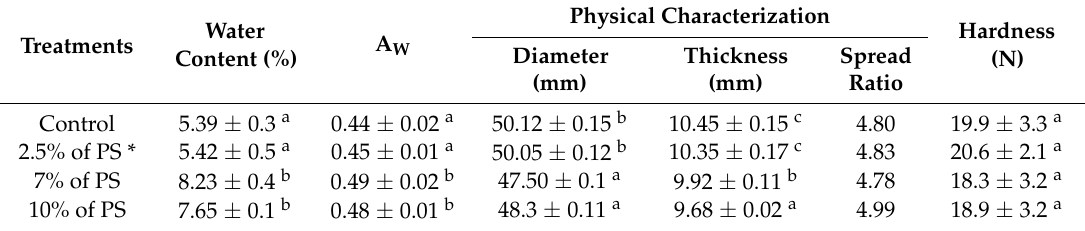
Table 5. Water content, A W , physical characterization, and texture analysis of the resulting cookies with added citric